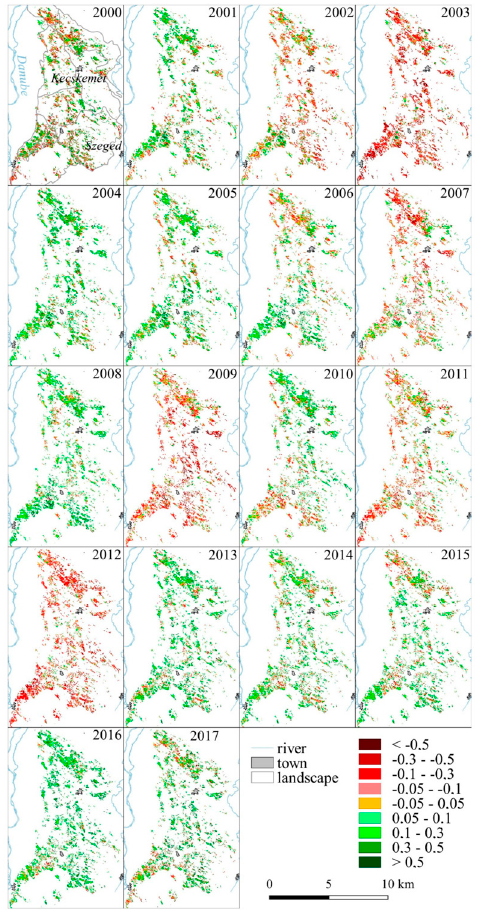
Figure 7. Spatiality of EVI standardized deviation for forests in the Danube–Tisza Interfluve between 2000 and 2017 in 250 m spatial resolution MODIS MVC